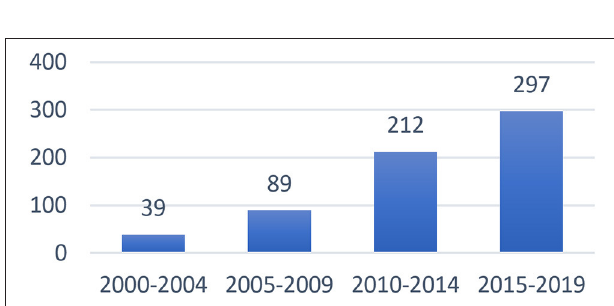
FIGURE 2 | Numbers of the articles on scaffolding in 5-year intervals.